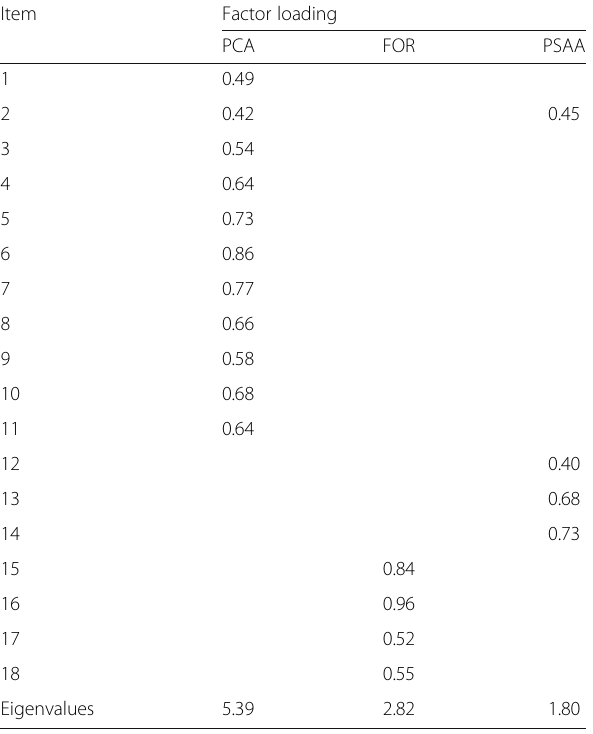
Table 2 Factor analysis of the MAX-PC with oblique